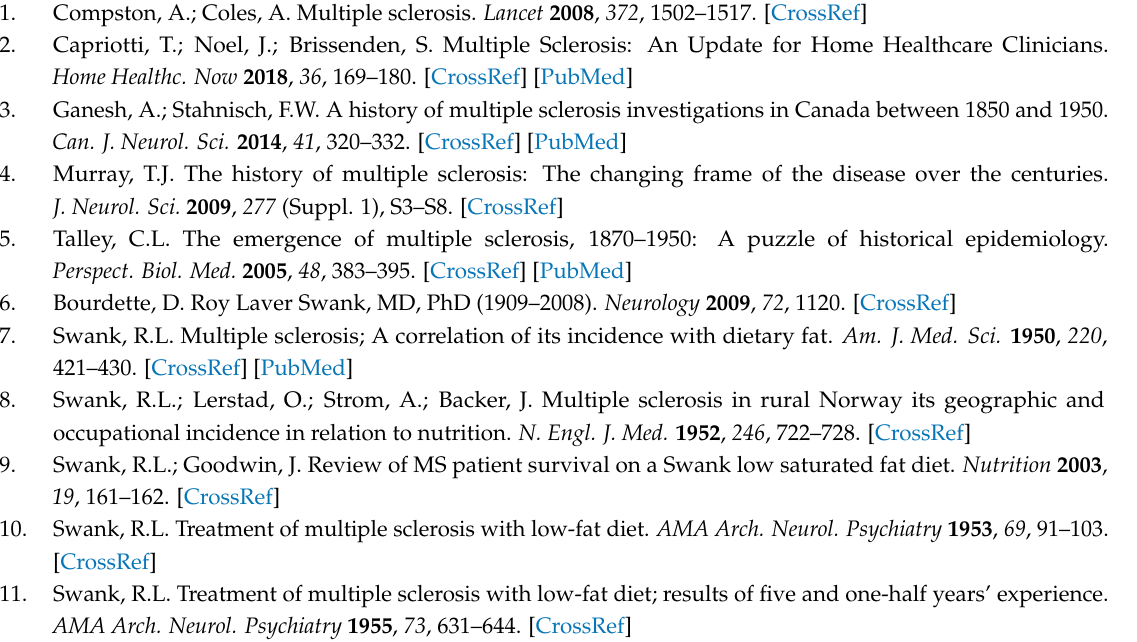
Table S1. Food descriptions and amounts used to calculate the nutrient composition of the seven-day low saturated fat Swank menus. Table S2. Healthy Eating Index-2015 (HEI-2015) and Alternate Healthy Eating Index-2010 (AHEI-2010) components. Table S3. Nutrient composition of dietary supplements prescribed for low saturated fat Swank diet. Table S4. Alternate Healthy Eating Index-2010 (AHEI-2010) component and total score for 1800